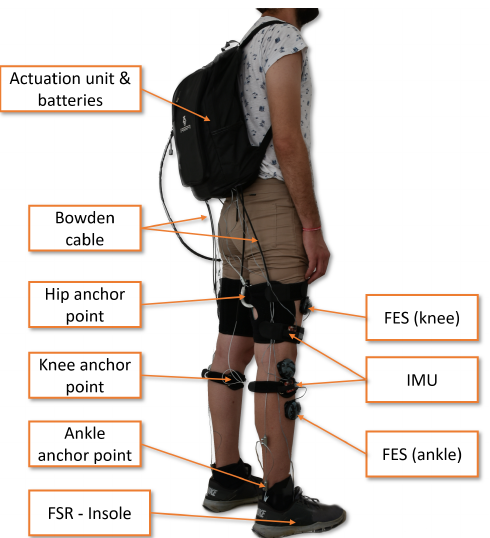
Figure 1. Exoskeleton developed for the project PID2019-107491RB-I00 (Spanish Agency of Research— MCIN/AEI/10.13039/501100011033). Sensors and